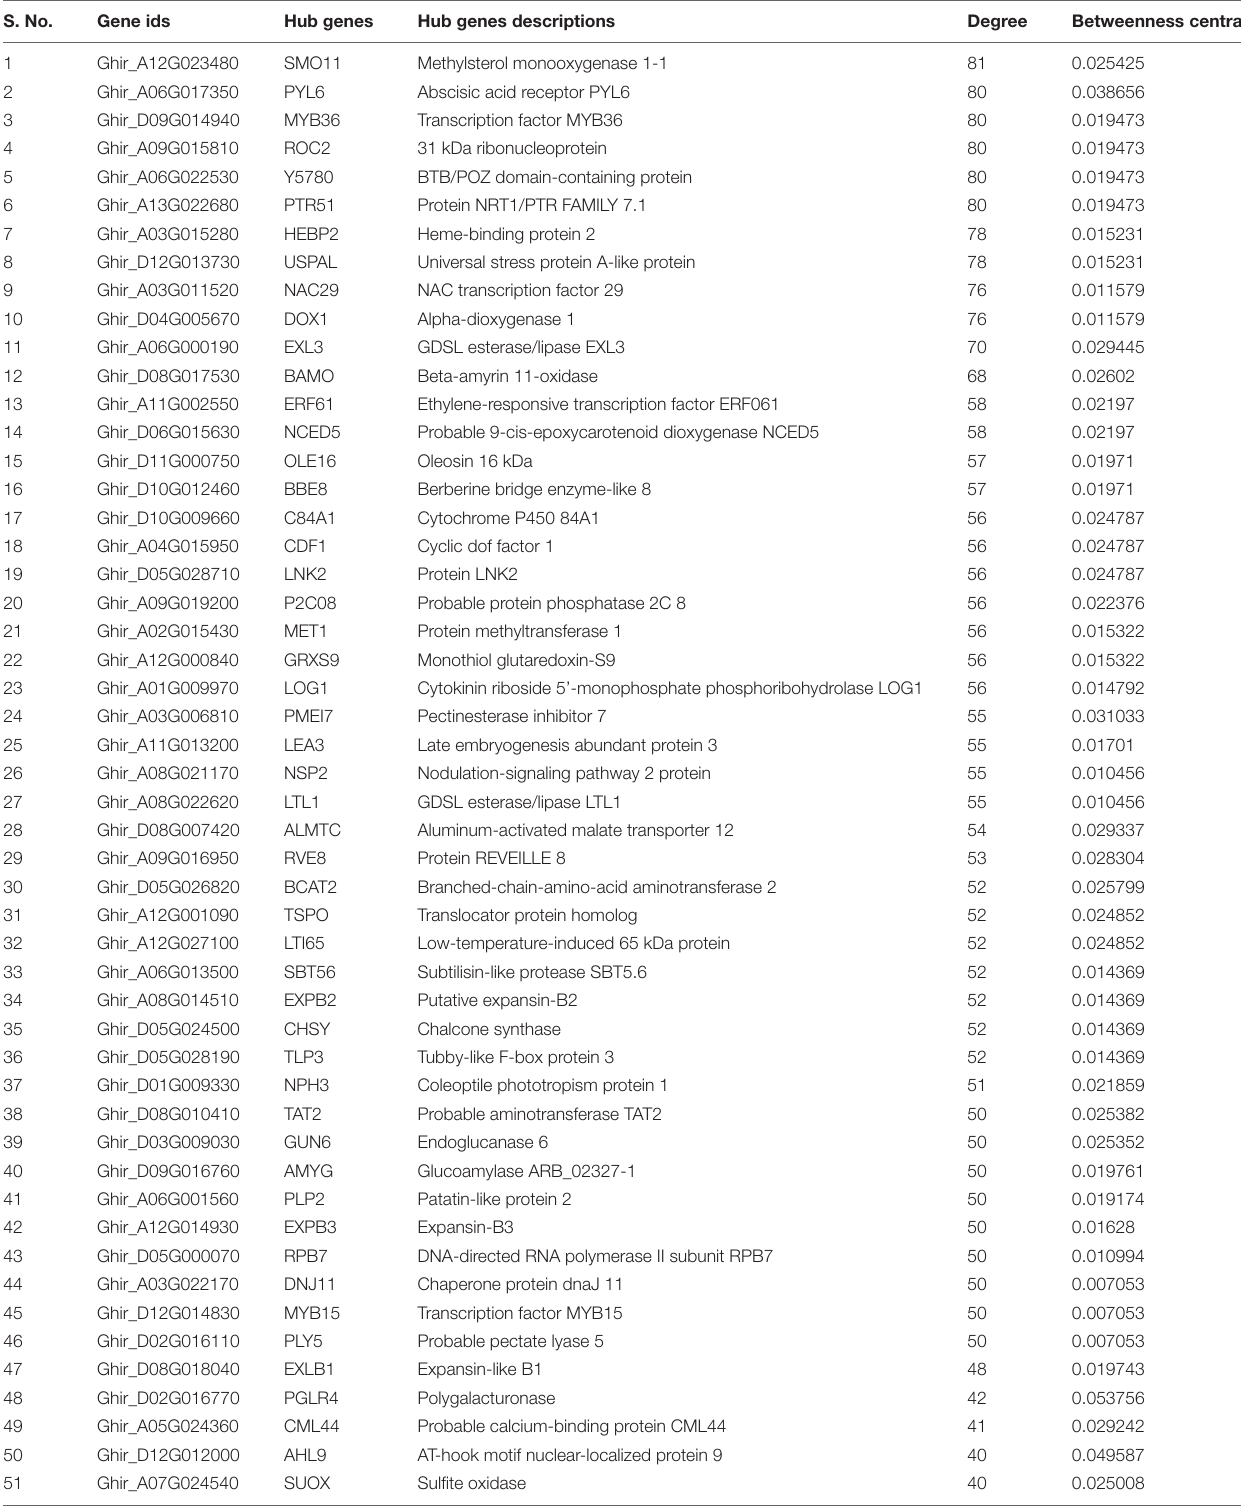
TABLE 1A | Top 86 hub genes based on the topological properties in co-expression network of DEGs in drought stress condition, and arranged on the basis of the decreasing degree of connectivity value. S.